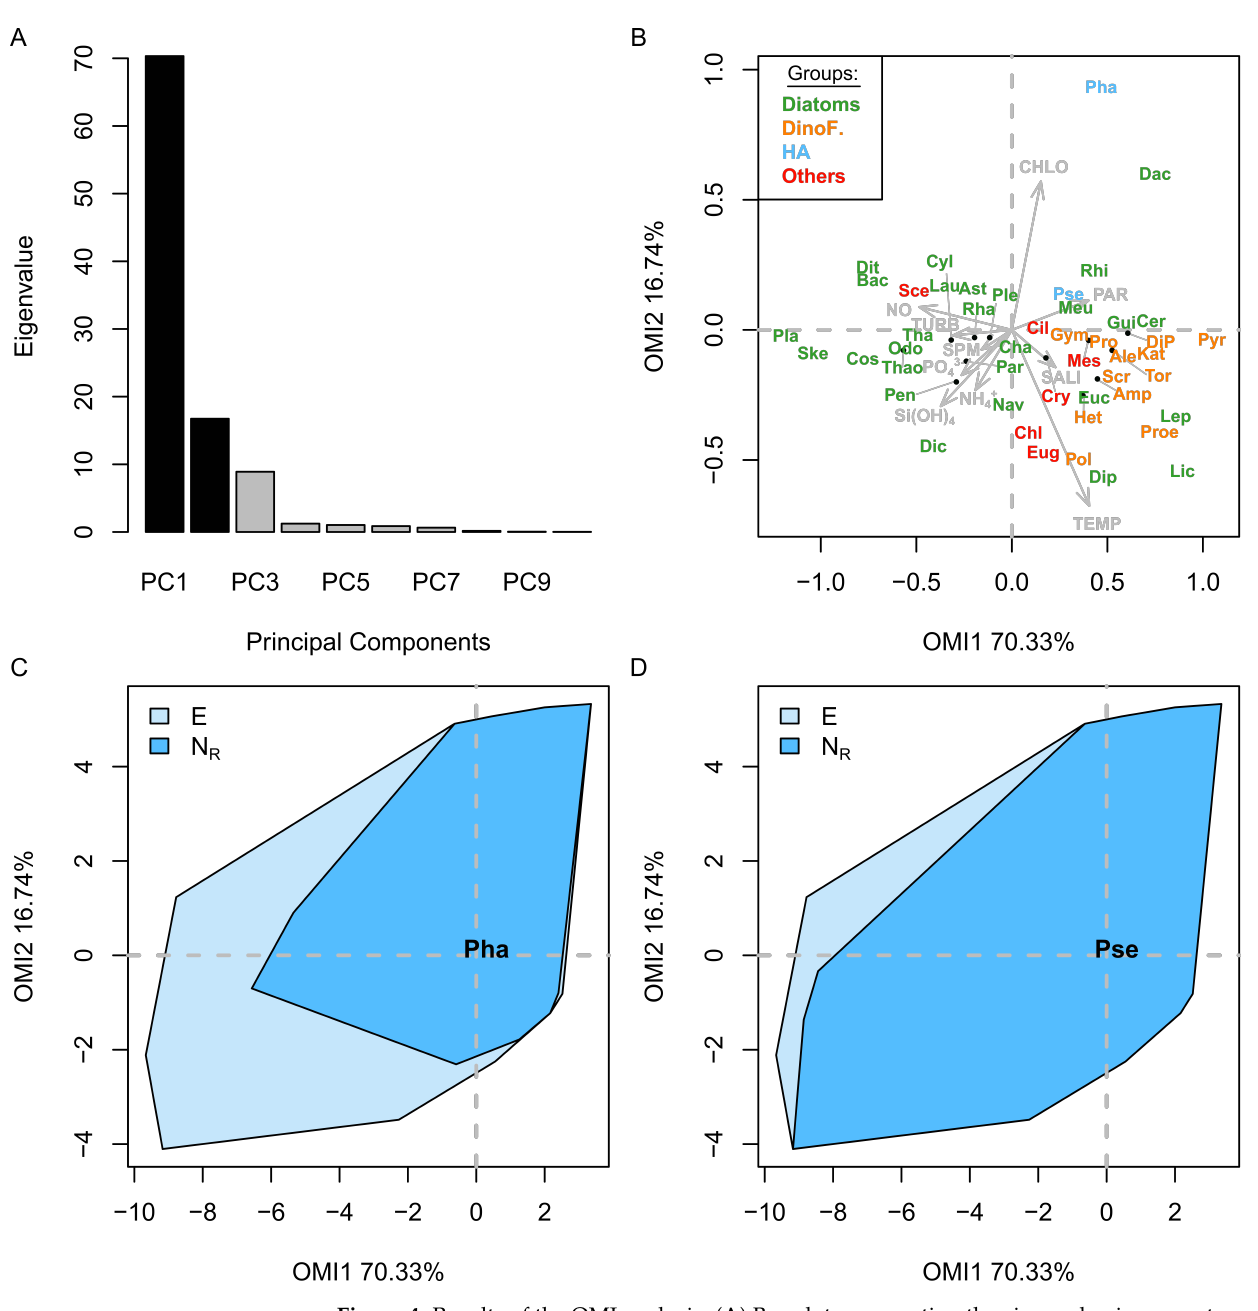
Figure 4. Results of the OMI analysis. ( A ) Bar plot representing the eigenvalue in percentages of the total sum. The black bars are the chosen factorial axis PC1 and PC2, which are named OMI1 and OMI2 for the other graph. ( B ) Representation of the significant species’ realized niche positions on the first two factorial axes with the canonical weights of environmental variables (SPM, suspended particulate matter; NH 4+ , ammonium concentration; NO, nitrate + nitrite concentration; PAR, photosynthetic active radiation; PO 43 − , phosphate concentration; TEMP, temperature; SALI, salinity; Si(OH) 4 , silicate concentration; TURB, turbidity and CHLO, the concentration of chlorophyll- a ). The two niche positions of the two taxa of interest, the complex Pseudo-nitzchia (Pse) and Phaeocystis globosa (Pha), are represented by the blue labels, respectively. The main groups of phytoplankton are represented by the different colors (Diatoms in green, Dinoflagellate in orange, and other groups in red). ( C , D ) are the representations of the realized niche, N R , position (black label) and breadth (blue polygon) found within the environmental space E (light blue polygon) for Phaeocystis globosa (Pha) and for the complex Pseudo-nitzchia (Pse)